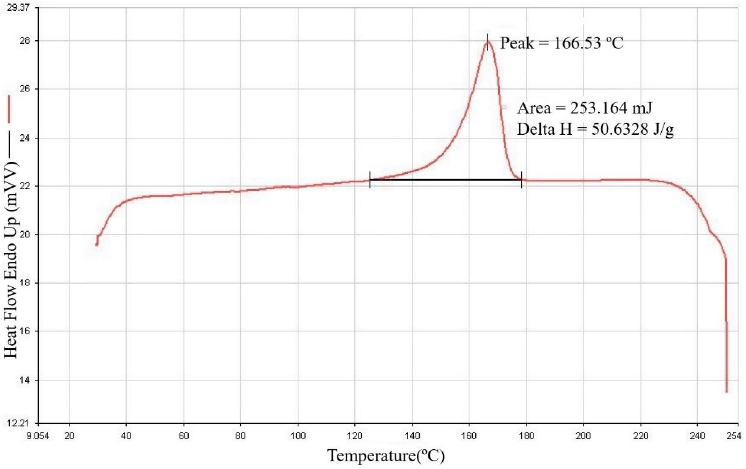
Figure 6. DSC analysis of PP.